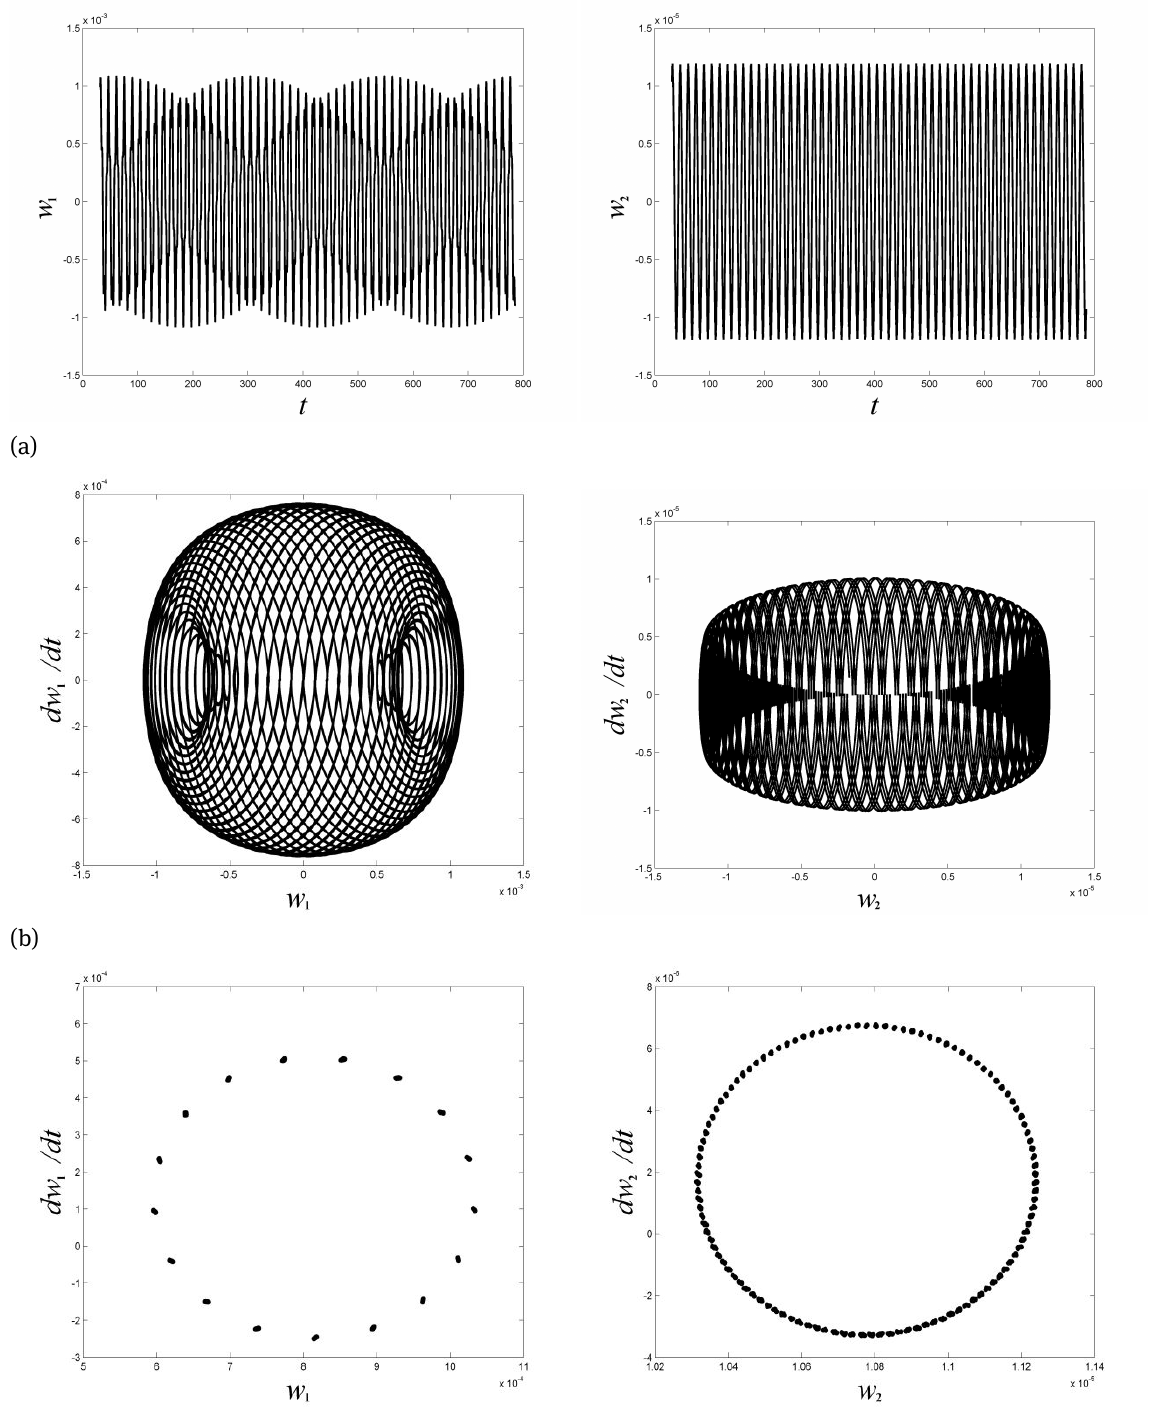
Fig. 2. Periodic behaviors of the cantilever beam system shown in wave diagrams (a), phase diagrams (b) and Poincaré maps (c), q